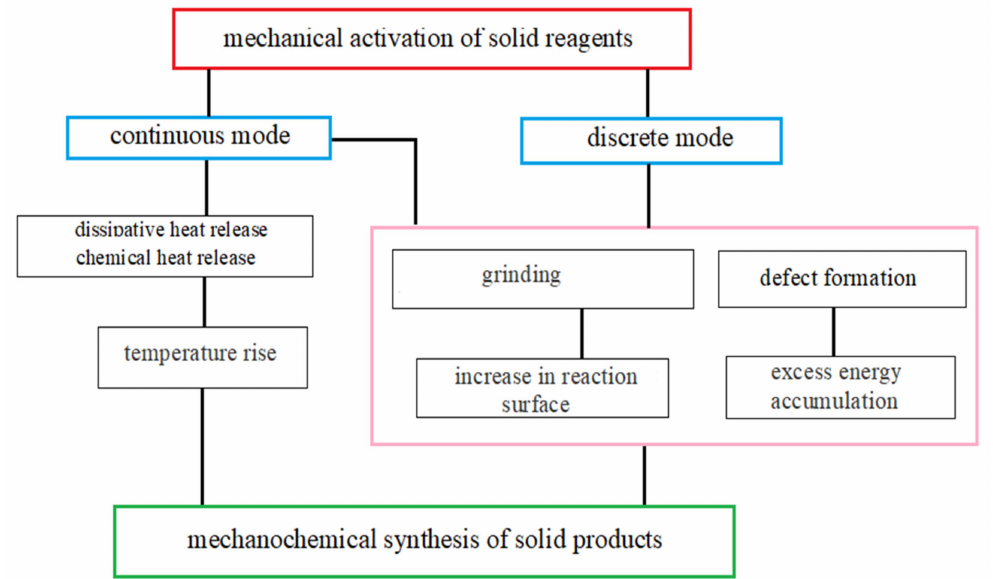
Figure 1. Factors accelerating chemical transformations during the synthesis of a solid-phase product (titanium nitride) when a solid reagent (titanium) is subjected to mechanical activation in a gas